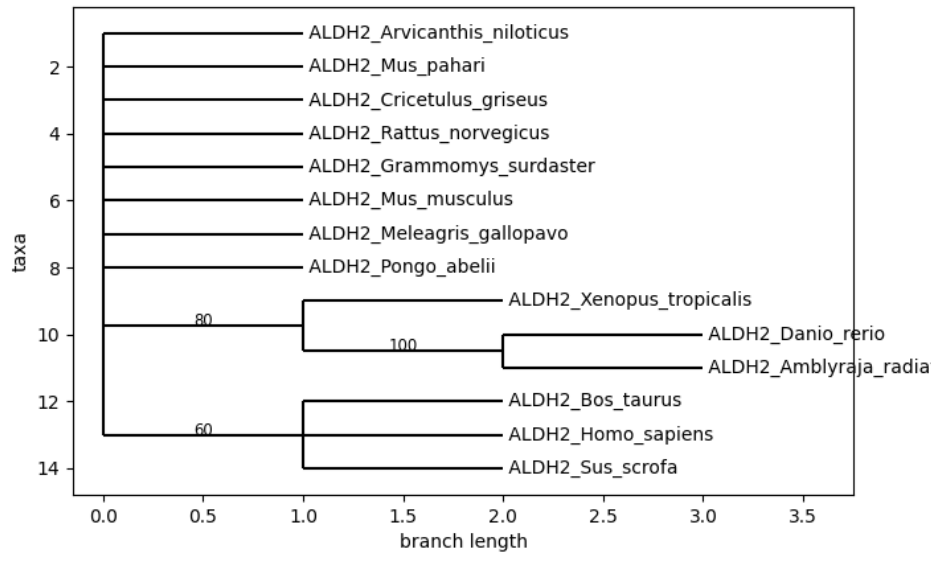
Figure 19. Majority consensus tree built from multiple trees generated using physicochemical properties, secondary structure, fractal dimension, Shannon entropy, and Hurst